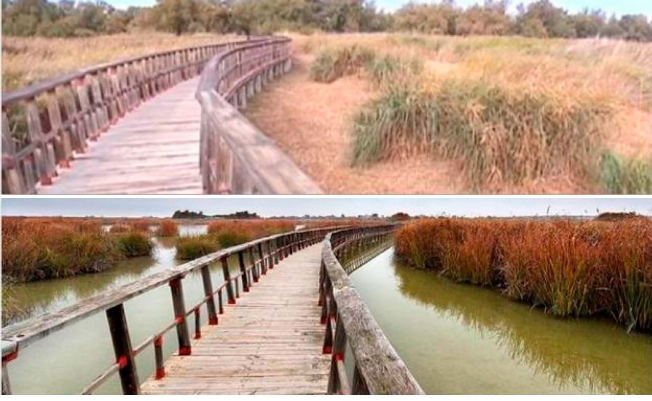
Figure 4. Comparison of an area of the park between 2013 and